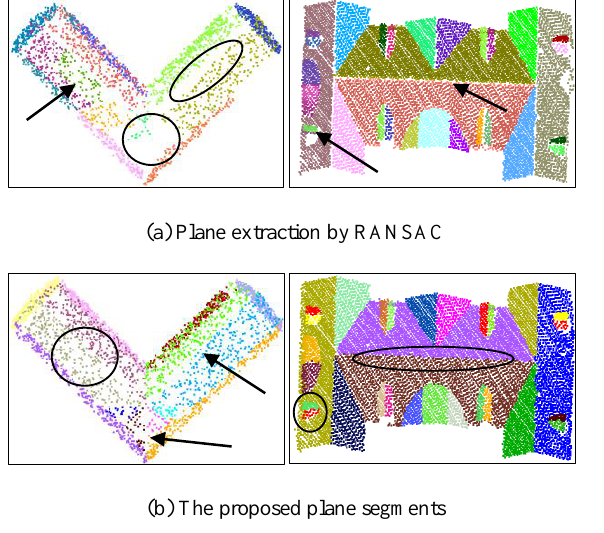
Figure 3. Comparison of plane segmentation from S1 and